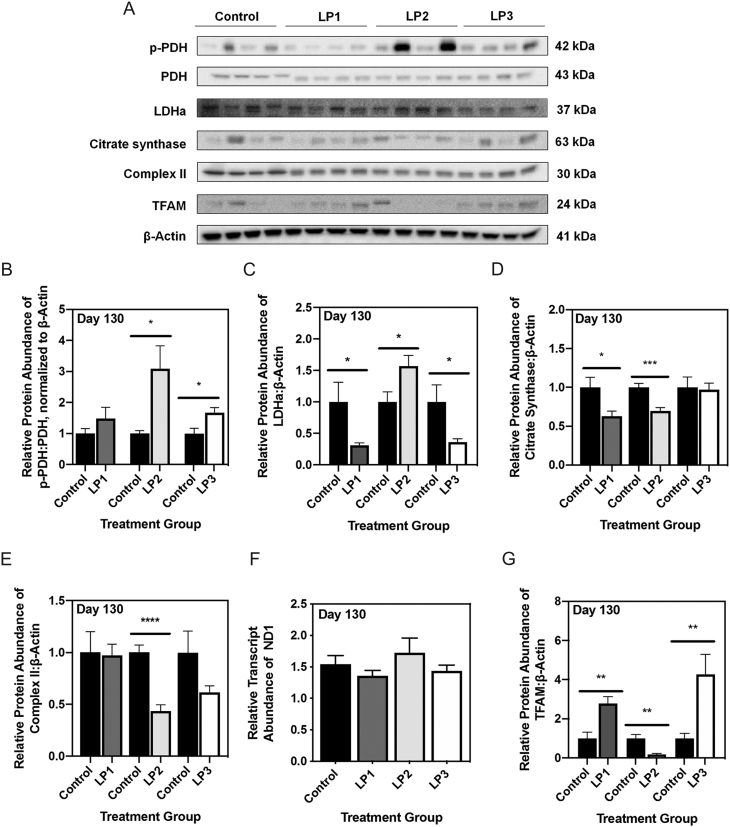
Maternal protein restriction and postnatal catch-up growth together lead to aberrant markers of aerobic metabolism at 4 months of age. (A) Representative Western immunoblots for specific targeted protein bands for control, LP1, LP2 and LP3 offspring as detected by primary antibodies. Protein abundances of (B) phosphorylated pyruvate dehydrogenase (PDH) to total PDH, (C) lactate dehydrogenase subunit A (LDHa), (D) citrate synthase, (E) complex II, and (G) mitochondrial transcription factor A (TFAM) in LP1, LP2 and LP3 offspring were compared against control diet-fed offspring and expressed as means normalized to β-Actin ± s.e.m. (n = 7–8/group). (F) Transcript abundance of NADH:ubiquinone oxidoreductase core subunit V1 (ND1), a marker of mitochondrial number, was expressed as means normalized to geometric means of β-Actin and GAPDH ± s.e.m. (n = 7–8/group). All qRT-PCR data were analyzed using a one-way ANOVA and multiple comparisons test, while protein abundances were compared using a two-tailed unpaired Student’s t-test. *Significant difference (P < 0.05), **significant difference (P < 0.001), ****significant difference (P < 0.0001).